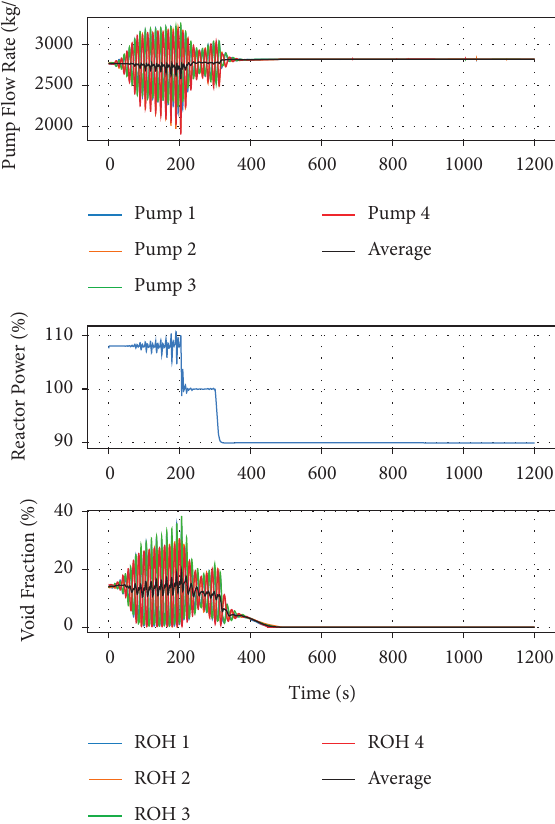
Figure 25: Flow oscillations at 108% full power, with power re- duced to 100% after 200 seconds and to 90% after 300 seconds. The even pair of pumps and headers oscillate out-of-phase with the odd